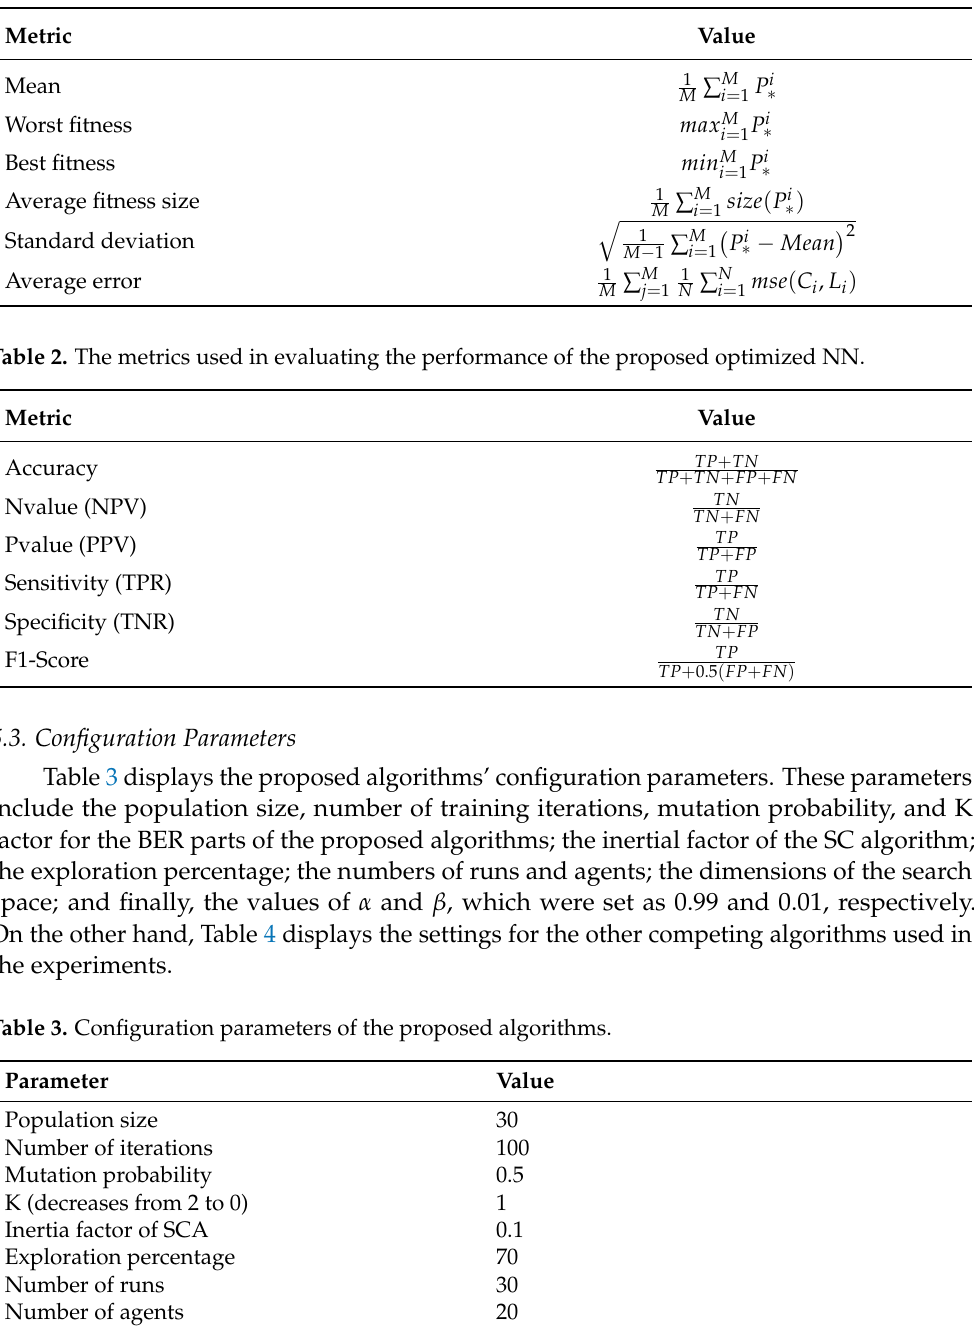
Table 1. The metrics used in evaluating the performance of the proposed feature selection method.